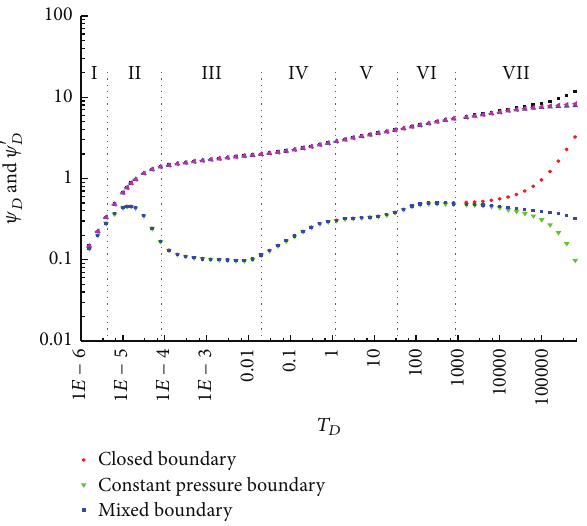
Figure 6: Typical curve of CBM horizontal well with complex boundary conditions ( 𝜔 = 0.01 , 𝜆 = 300 , 𝛽 = 50 , 𝐿 𝐷 = 2.5 , = 0.5 , 𝐶 = 0.0001 , 𝑠 = 1 , and 𝑟 𝑍 𝑤𝑑 𝑑